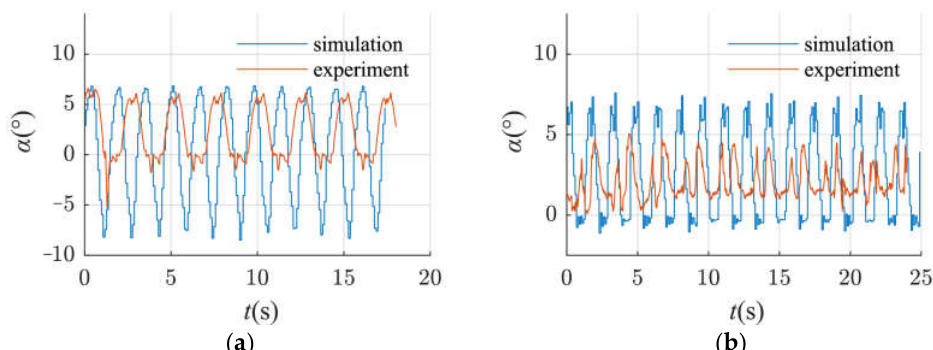
Figure 18. Comparison of simulation and experimental data. ( a ) Pitch angle of head module without stabilization algorithm; ( b ) pitch angle of head module with stabilization algorithm.